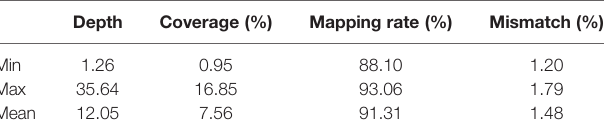
TABLE 2 | Sequencing statistics.